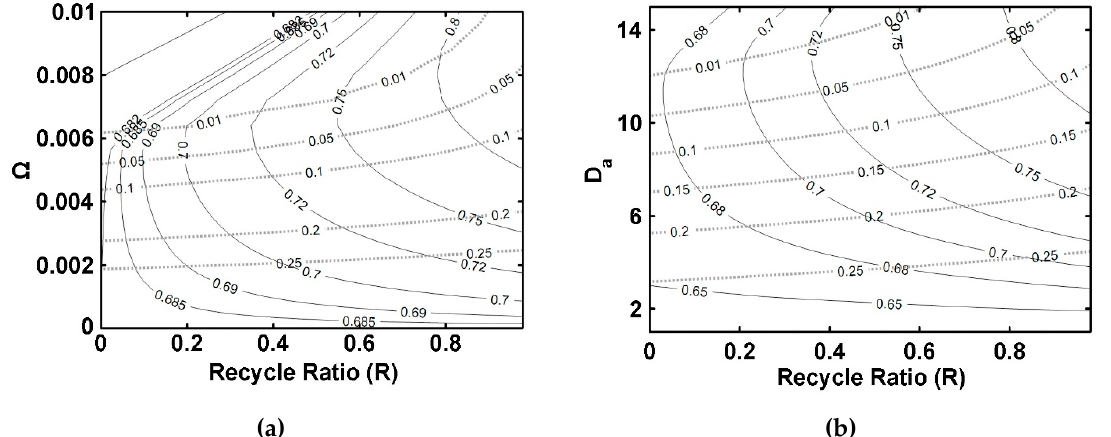
Figure 12. Design charts for a SR+PVMU ( Configuration 2 ) with ( a ) D a = 12 and ( b ) Ω = 0.008. Notes: (i) Ester yields: continuous lines, (ii) Retentate water molar fractions: dashed lines.